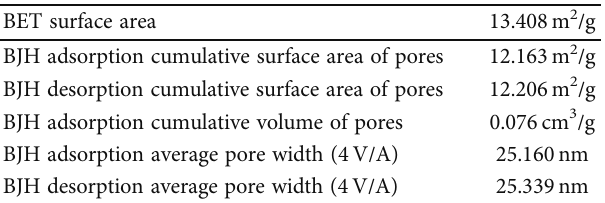
Table 1: The physicochemical characteristics of M-ARM.